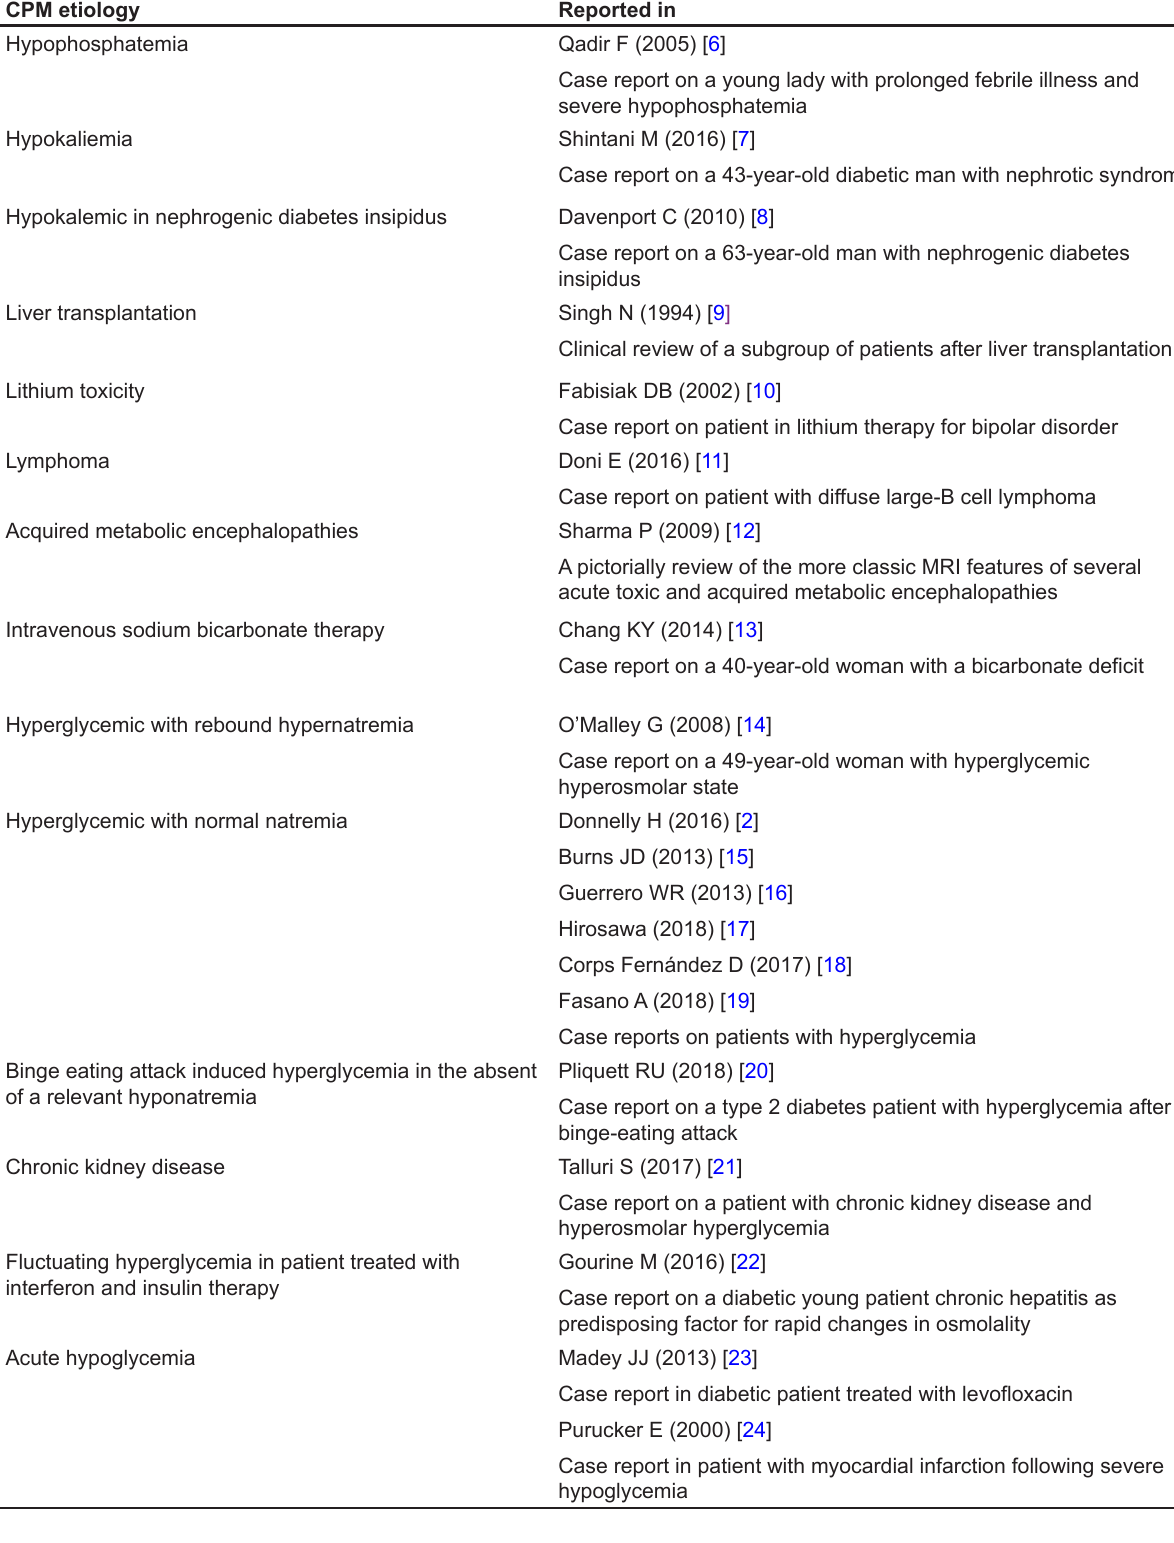
Table 2. Systematic review—CPM in a variety of clinical settings ( continued